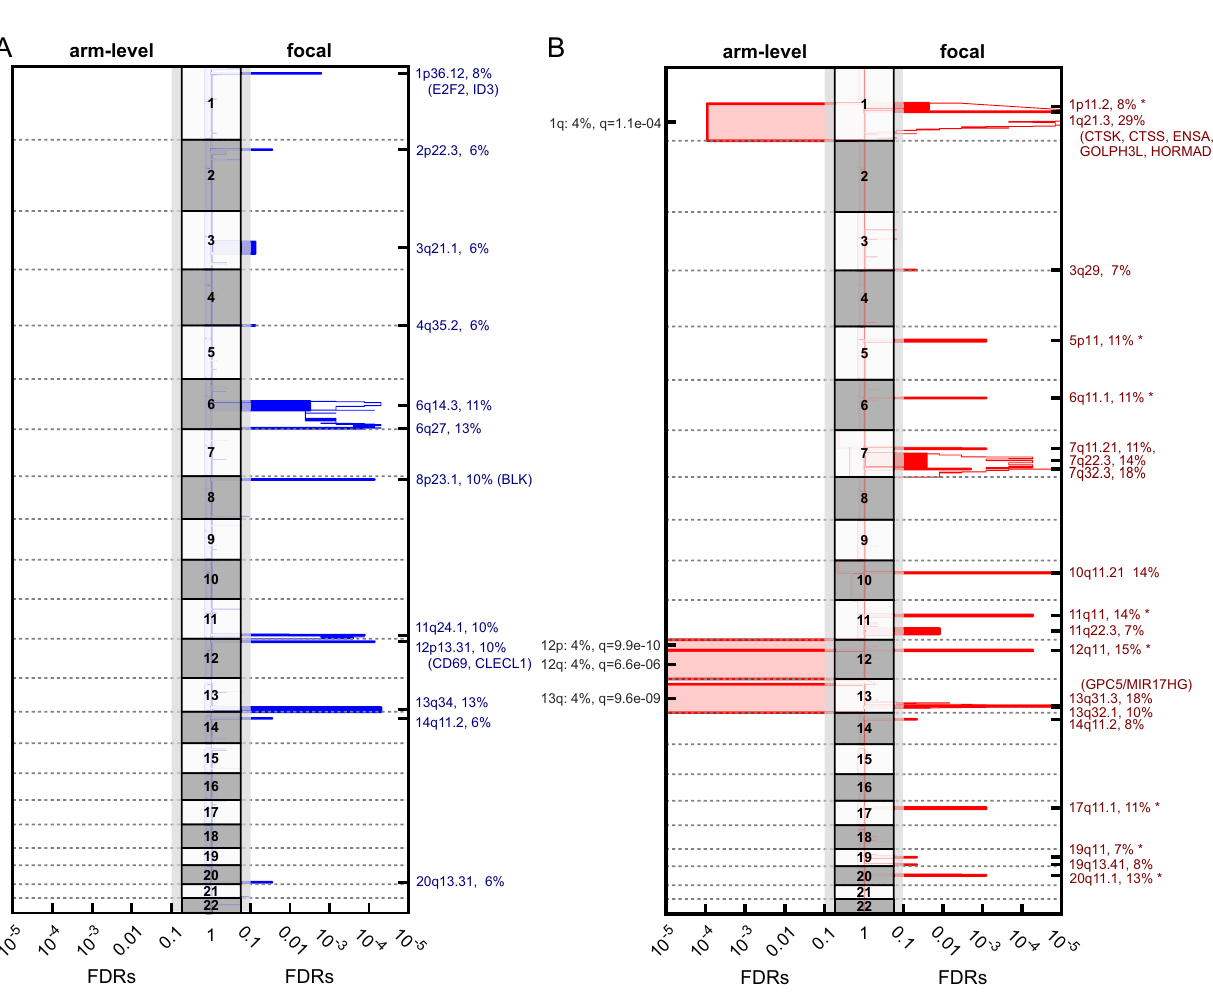
Fig. 2 Somatic copy number aberrations (SCNAs). Signi fi cant recurring SCNAs are displayed as blocks, based on 72 pediatric cases (55 BL and 17 B-AL cases). Curves indicate residual q -values by GISTIC 2.0 after explaining broad aberrations (Supplementary Data 7). A Focal deletions affecting E2F2 and ID3 were detected. B The most consistently observed SCNA contains GPC5 ( q = 1.8e-9). Notably, the non-protein-coding MIR17HG cluster directly precedes this gene and is also affected by these gains and ampli fi cations (Supplementary Data 6). *: might represent benign (germline) copy number DDX3X SNV/indels are predominantly identi fi ed in pediatric Burkitt lymphoma . Dead box helicase 3 ( DDX3X ) encodes an